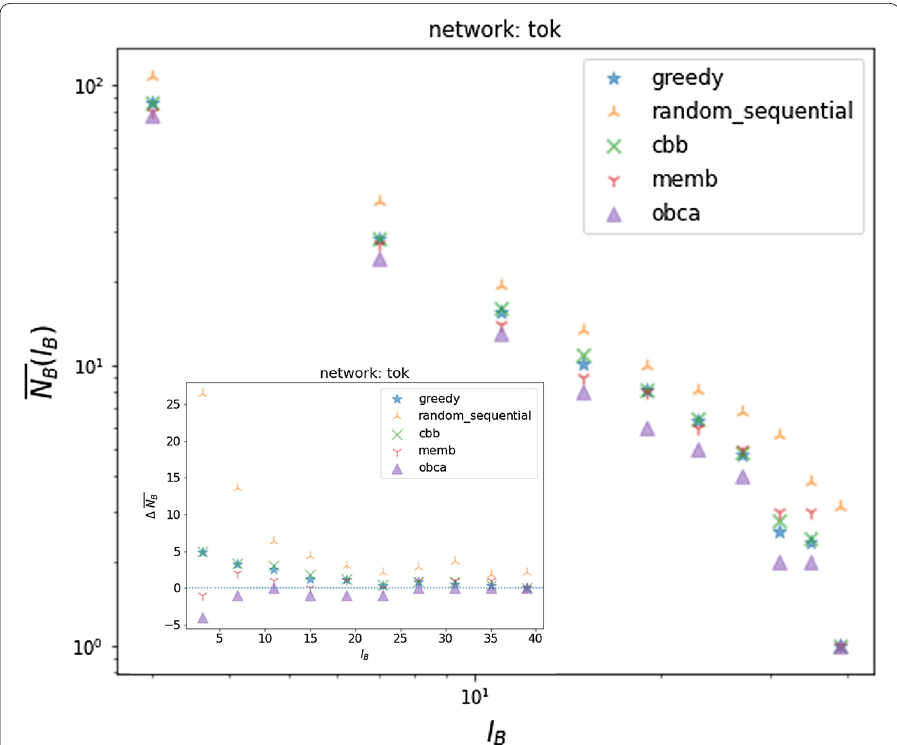
Fig. 5 The mean N B against l B computed on the Tokyo metro network with five different algorithms. The inset plot shows the corresponding � N B ( l B ) values, which are the difference of the mean N B and the minimum of the 15 boxing of the greedy